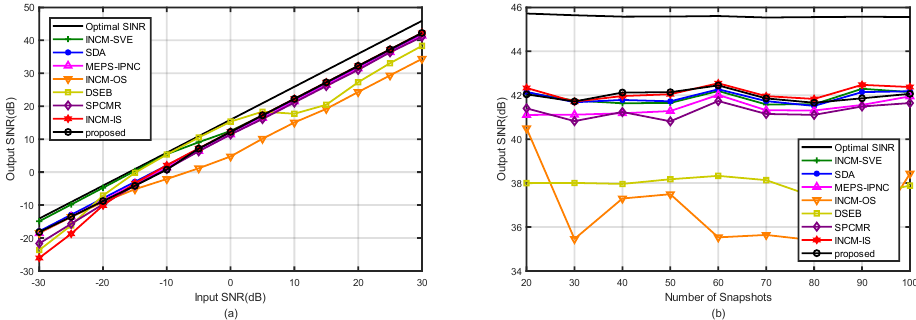
Figure 6. Output SINRs in the case of coherent local scattering error versus ( a ) input SNR with 𝐾 = 100 ; ( b ) the number of snapshots with 𝑆𝑁𝑅 = 30 dB .